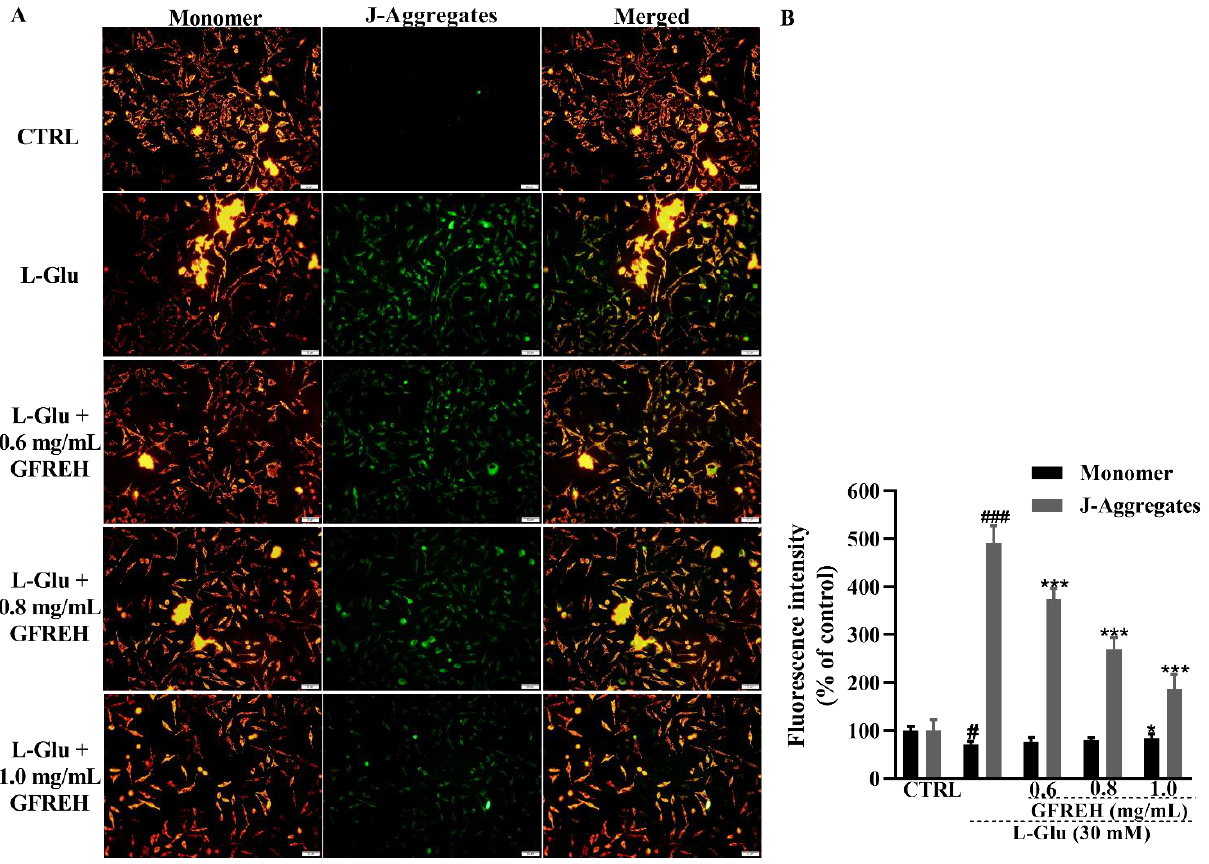
Figure 5. ( A ) The effect of MMP caused by 24 h L-Glu exposure was strongly restored by 4 h GFREH pretreatment, as analyzed by JC-1. Scale bar is 100 µ m. ( B ) Fluorescence quantification by ImageJ software (version: 1.51), (n = 3). The data are presented as the mean value ± SD. # p < 0.01 and ### p < 0.001 vs. CTRL, * p < 0.01 and *** p < 0.001 vs. L-Glu-treated cells.